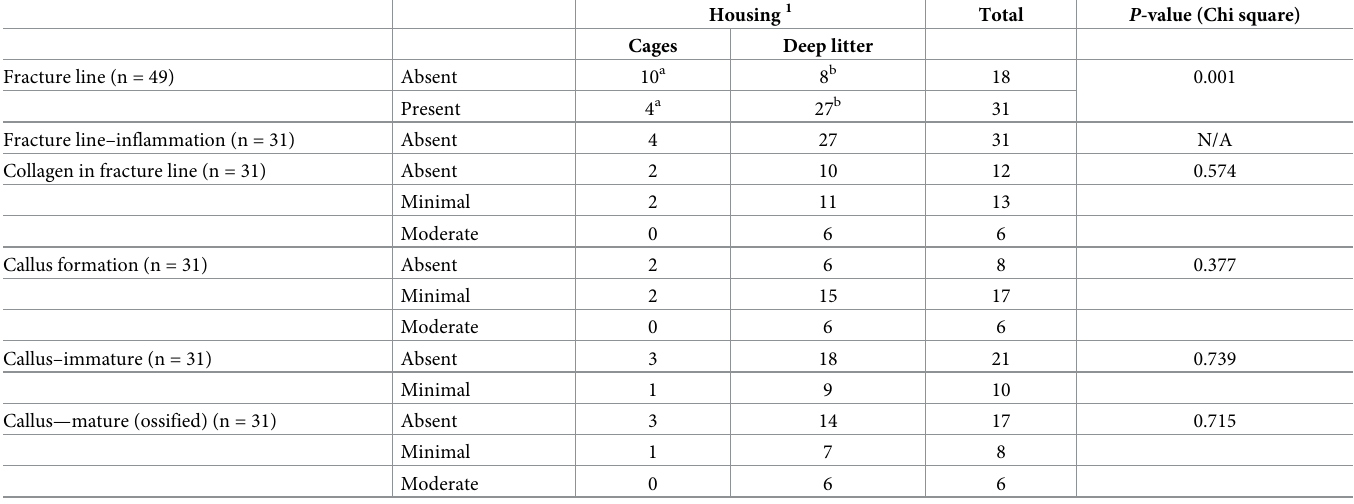
Table 5. Overview of fracture repair in old birds from different housing